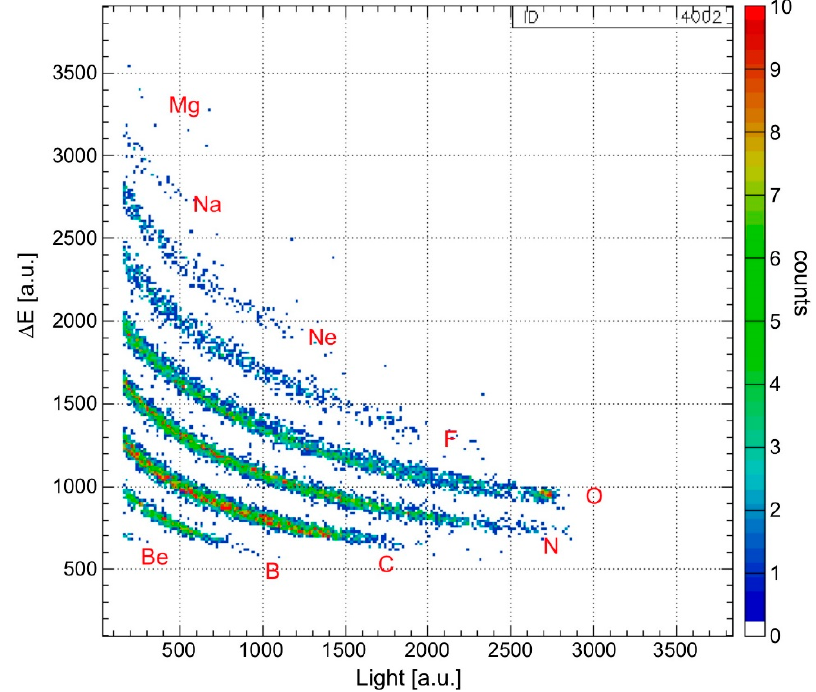
Figure 23. ∆ E − E r plot showing an excellent atomic number resolution ∆ Z/Z ≈ 0.16 between the nine adjacent nuclear species detected.